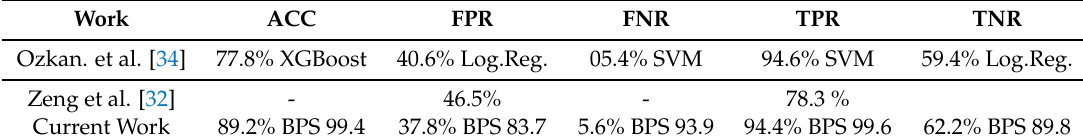
Table 7. Performance evaluation comparative results with the same dataset.